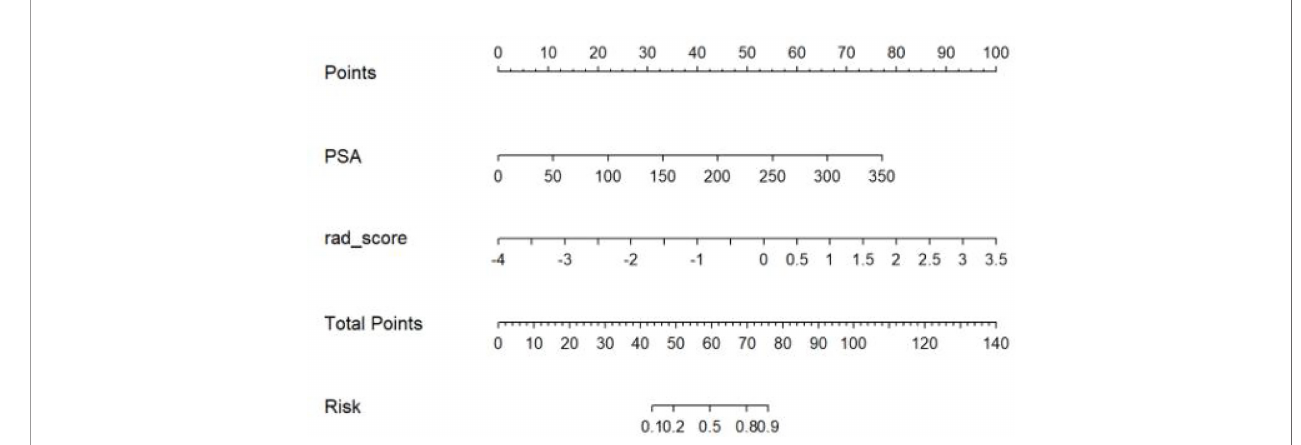
FIGURE 3 | Radiomic nomogram. A nomogram for identifying prostate cancer and prostatic hyperplasia.